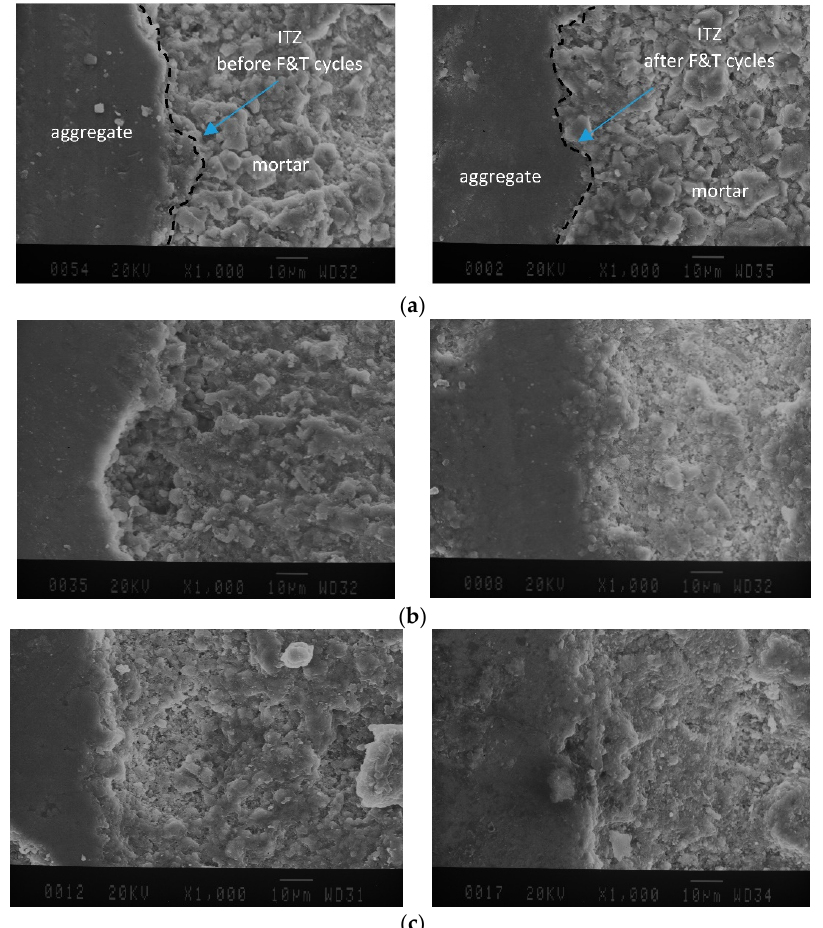
Figure 11. SEM images of ITZ before ( left ) and after ( right ) applying freeze-thaw cycles; ( a ) mix including pretreated RCA in desiccator, ( b ) mix using manually pretreated RCA, and ( c ) mix con- taining untreated RCA.; ( a ) RACCD w/c ratio 0.30, ( b ) RACCM w/c ratio 0.30, and ( c ) RAC w/c ratio 0.30.